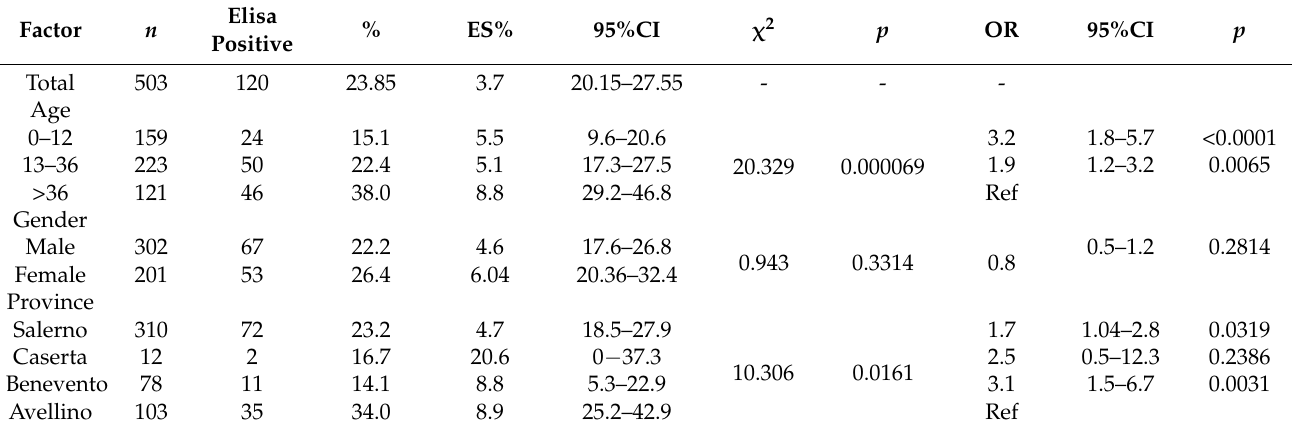
Table 1. Seroprevalence of infection with ADV and risk factor analysis by age, gender and location in Wild Boars in the Campania Region as detected by competitive